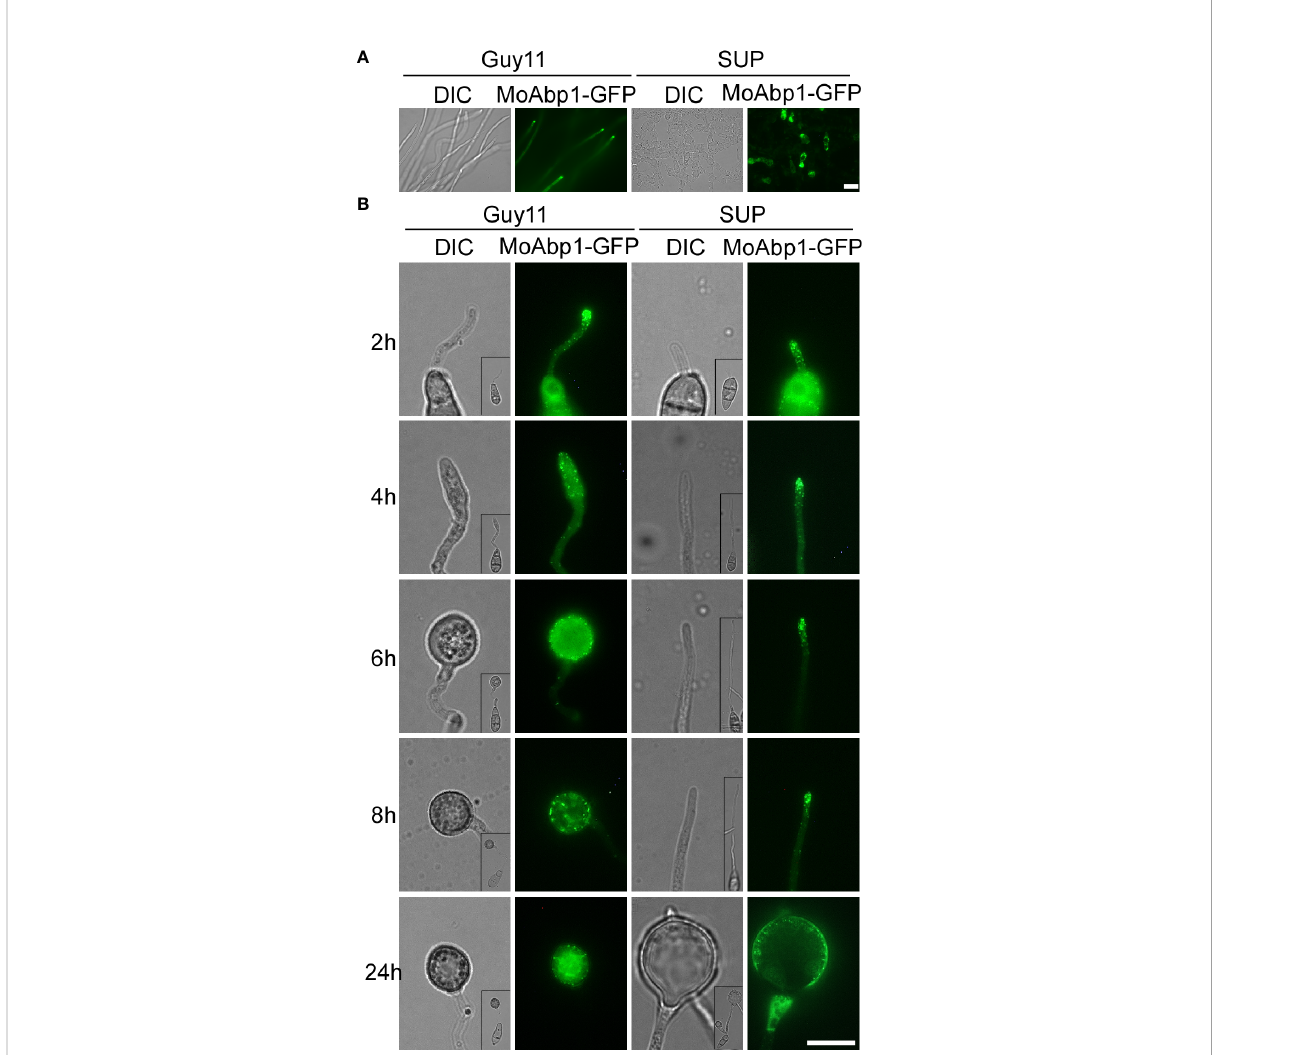
FIGURE 4 KC81 SUP impairs actin cytoskeleton organization of M. oryzae . (A) Live cell imaging experiment to show MoAbp1-GFP (green fl uorescent protein) localization in M. oryzae mycelium in the presence or absence of KC81 SUP. (B) Live cell imaging experiment to show MoAbp1-GFP localization during M. oryzae appressorium development in the presence or absence of KC81 SUP. Bar = 10 m